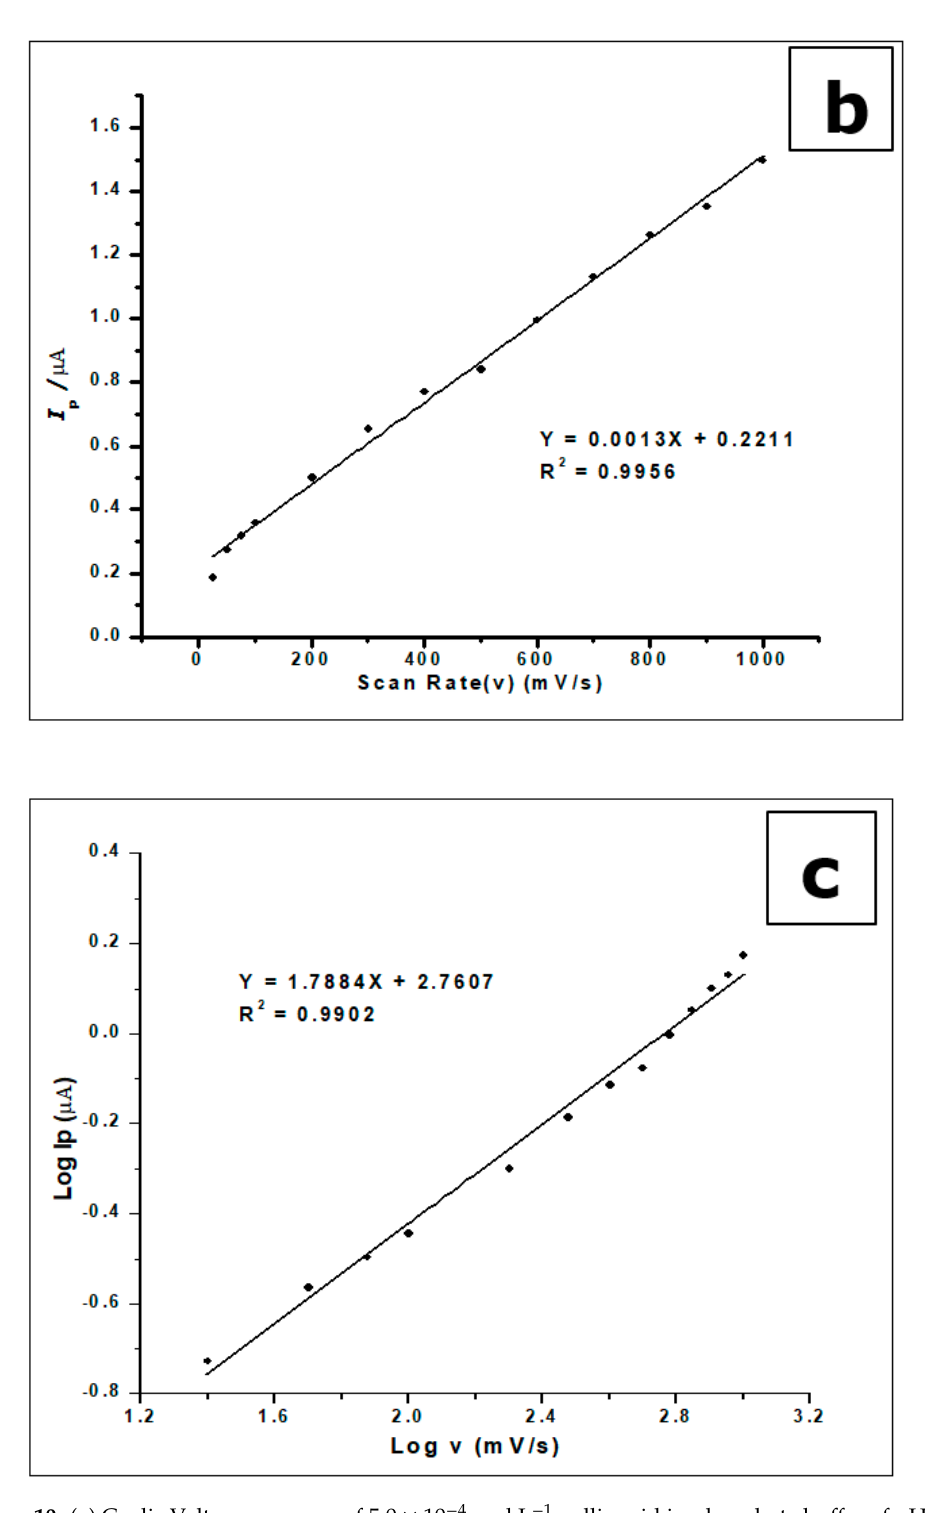
Figure 10. ( a ) Cyclic Voltammograms of 5.0 × 10 − 4 mol L − 1 gallic acid in phosphate bu ff er of pH 2.0 determined with a ZrO 2 nanoparticles-modified CPE at di ff erent scan rates from 25 to 1500 mVs − 1 . ( b ). The plot of the scan rate vs. the peak current ( c ). The plots of log I p vs. log ν showing straight